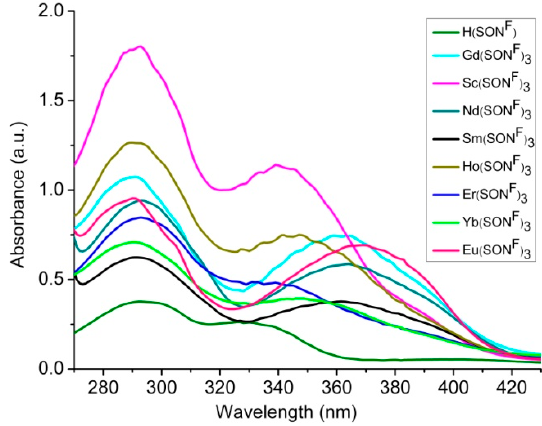
Figure 5. Absorption spectra of ligand H(SON F ) and complexes 1 – 8 in THF solutions.